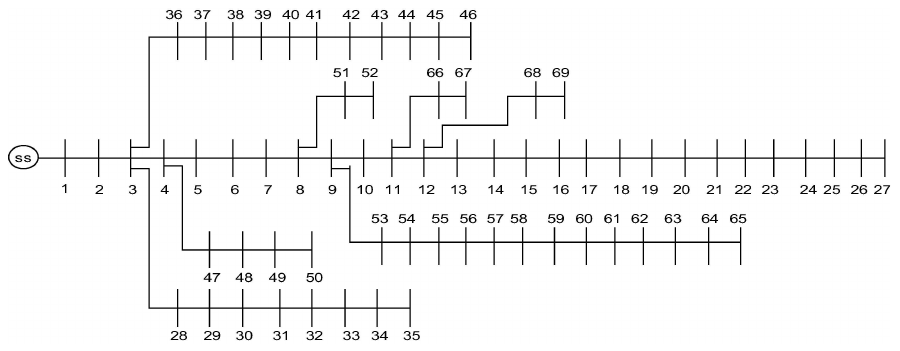
Figure 5. IEEE 69-node test system–NW-2. The total power of 100 MVA and voltage of 12.66 kV are considered as base values in the network. For NW-2 the losses are 224.9 kW and 102.17 kVAr, and the minimum voltage of 0.9092 pu appears at node 65 in base case. The computation time taken for 30 iterations is 70.18 s. For IEEE, a 69-node radial network voltage profile after DG placement with MBA and SPPA is compared with the base case. SPPA showed better results than other two. After the optimal placement of DG with the SPPA technique, a significant improvement in voltage profile was observed and the minimum voltage occurs at node 28, which is 0.9782 pu, and after MBA the minimum voltage is 0.978 pu. Graphical representation is shown in Figure 6.